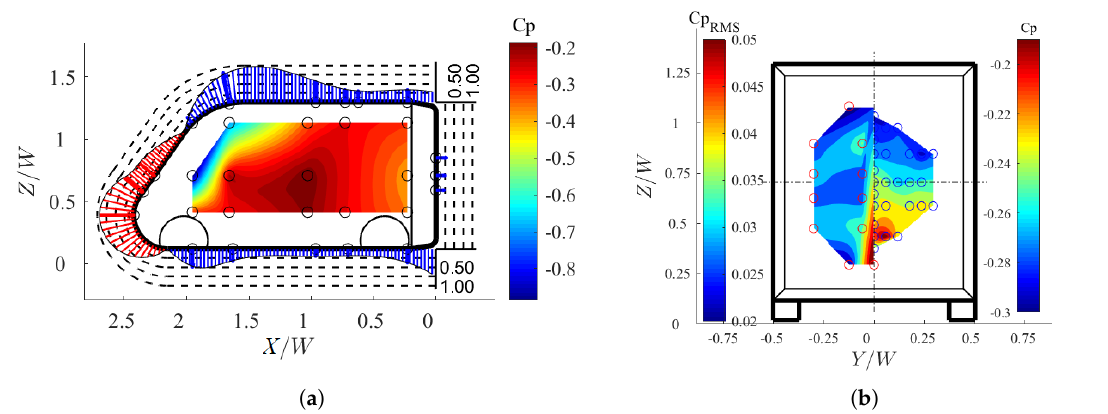
Figure 4. Natural flow. ( a ) Mean pressure distribution on the lateral surface and in the symmetry plane (vectors are obtained by interpolating the pressure taps readings with a spline curve), where black circles indicate the physical location of the static probes on the top and lateral surface, respectively. ( b ) Static pressure (right) and fluctuating pressure (left) distribution on the rear face. The location of the actual measurement points is schematically represented using blue and red circles for the static pressure and fluctuating pressure, respectively. The contour representation is obtained by interpolating the measurements on a structured grid. It is worth explicitly mentioning that the blue circles that populate the edges of the model are physically located along the plane of symmetry of the model (i.e., Y / W =